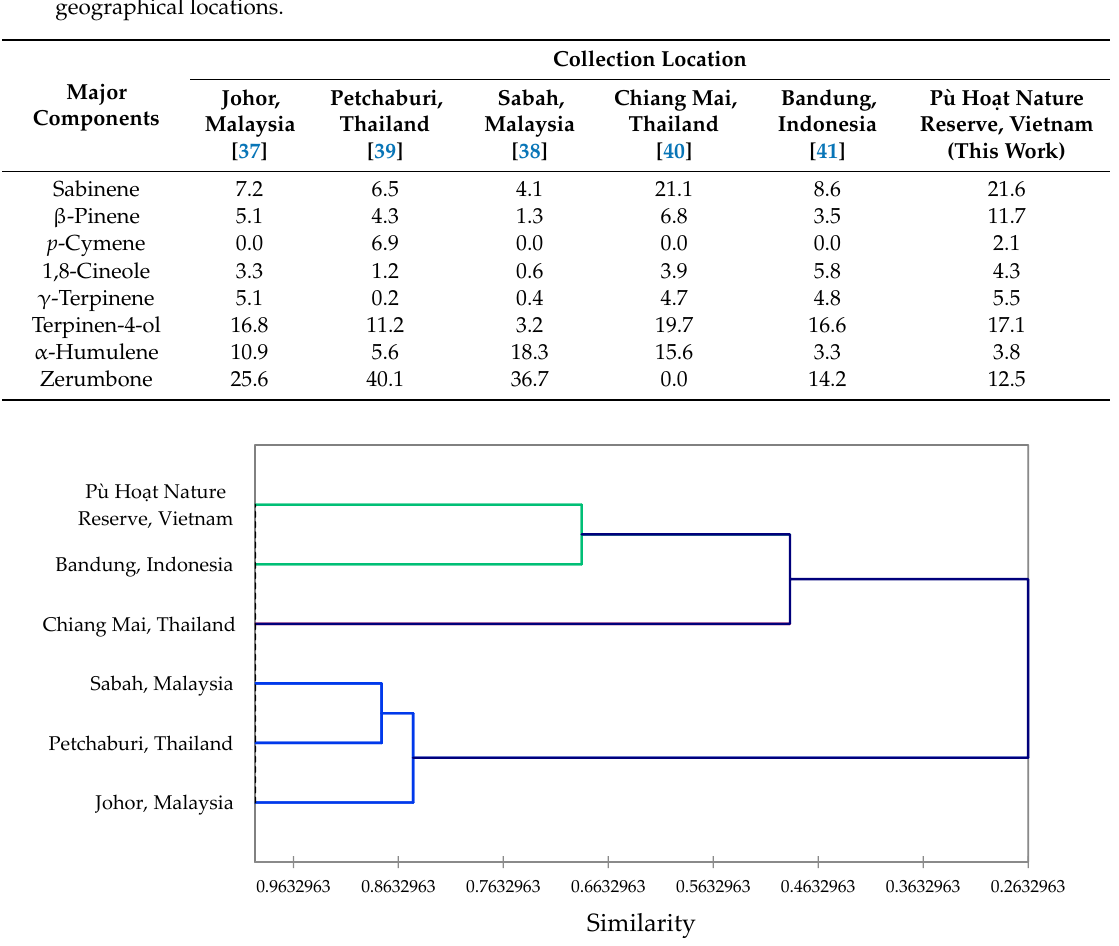
Figure 2. Dendrogram obtained from agglomerative hierarchical cluster analysis of the rhizome essential oils from Zingiber ottensii from different geographical locations.